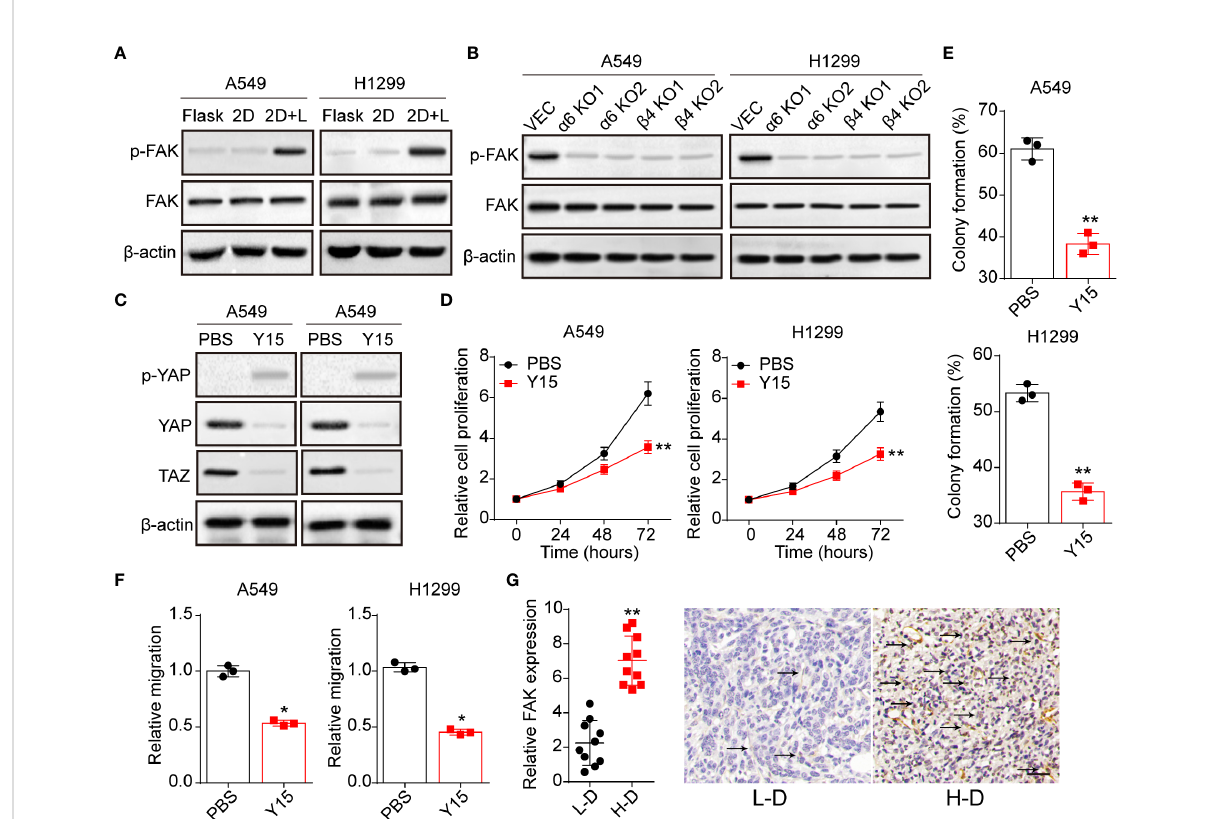
FIGURE 4 Laminin-induced YAP/TAZ activation is FAK-dependent. (A) , A549 and NCI-H1299 cells were cultured on fl ask, 2D collagen gels or 2D collagen gels containing laminin for 5 days. Then the expression of FAK and phosphorylated FAK were determined by western blotting. (B) , A549/NCI-H1299, integrin a 6 knockdown A549/NCI-H1299 and integrin b 4 knockdown A549/NCI-H1299 cells were cultured on 2D collagen gels containing laminin for 5 days. Then the expression of FAK and phosphorylated FAK were examined by western blotting. (C) , A549 and NCI-H1299 cells were cultured on 2D collagen gels containing laminin for 5 days, and PBS or Y15 (1 m M) was added into the culture medium. Then cells were collected and the expression of YAP, TAZ and phosphorylated YAP were determined by western blotting. (D) , tumor cells in (C) were collected and the proliferation was examined by CCK-8 analysis. E, tumor cells in (C) were collected and the colony formation capability was assessed. (F) , tumor cells in (C) were collected and the relative migrating cell numbers were examined by transwell analysis. (G) , immunohistochemical staining of phosphorylated FAK in high degree (H-D) and low degree (L-D) tumor tissues from NSCLC patients. The scale bar is 50 m m. *p < 0.05; **p <